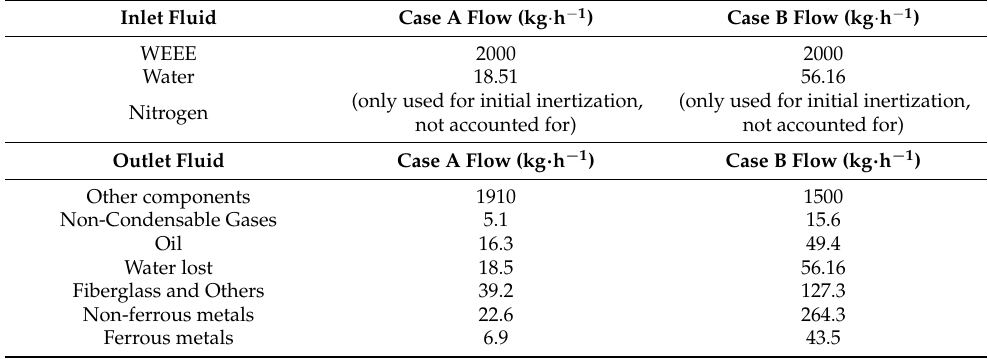
Table 2. Calculated flow rates and compositions of the inlet and outlet streams of the first part of the process.